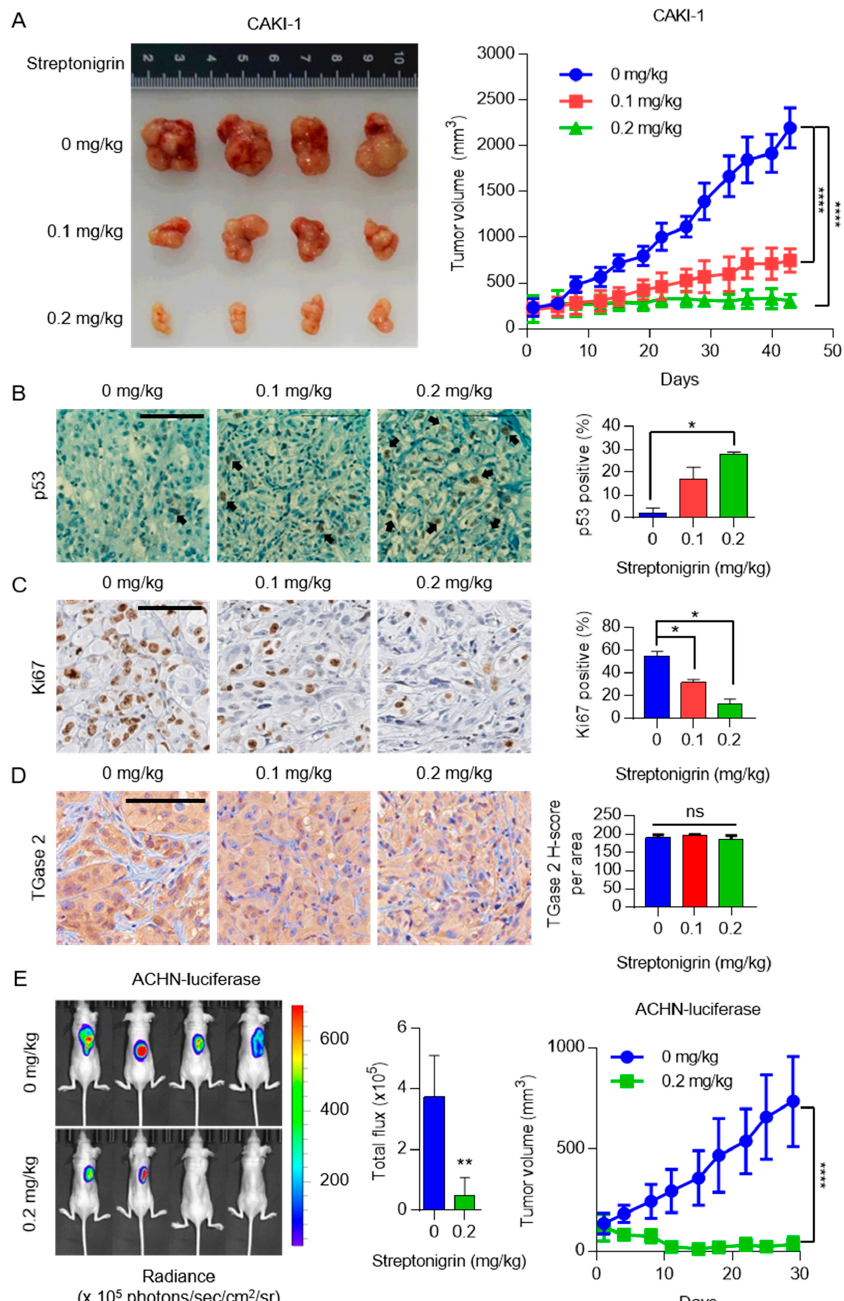
Figure 5. Streptonigrin shows anti-cancer activity in a human CAKI-1 xenograft model. ( A ) CAKI-1 cells were injected subcutaneously into one flank of BALB/c nude mice ( n = 4). Streptonigrin treatment was initiated when tumors reached a volume of 250 mm 3 . Photograph of tumors that developed in each group. The average volume of tumors in BALB/c nude mice is represented as the mean ± SD. ( B – D ) CAKI-1 tumors harvested from BALB/c nude mice were analyzed by immunohistochemistry using antibodies specific for ( B ) p53, ( C ) Ki67, and ( D ) TGase 2 (100 × magnification). Scale bar = 100 µ m. The bar graph represents the percentage of cells positive for p53 and Ki67. Data are expressed as the mean ± SD ( n = 3). ( E ) Luciferase-tagged ACHN cells were injected subcutaneously into one flank of BALB/c nude mice. Streptonigrin treatment was initiated when tumors reached a volume of 130 mm 3 . Each treatment group comprised four mice treated with vehicle (control), or with 0.2 mg/kg streptonigrin, for 29 days. Tumor growth was measured and calculated as described in the methods. The bar graph represents the Xenogen imaging signal intensity (photons/sec/cm 2 /steradian) at 30 days (mean ± SD, n = 4). ns p > 0.05, * p < 0.05; ** p < 0.01, and **** p <